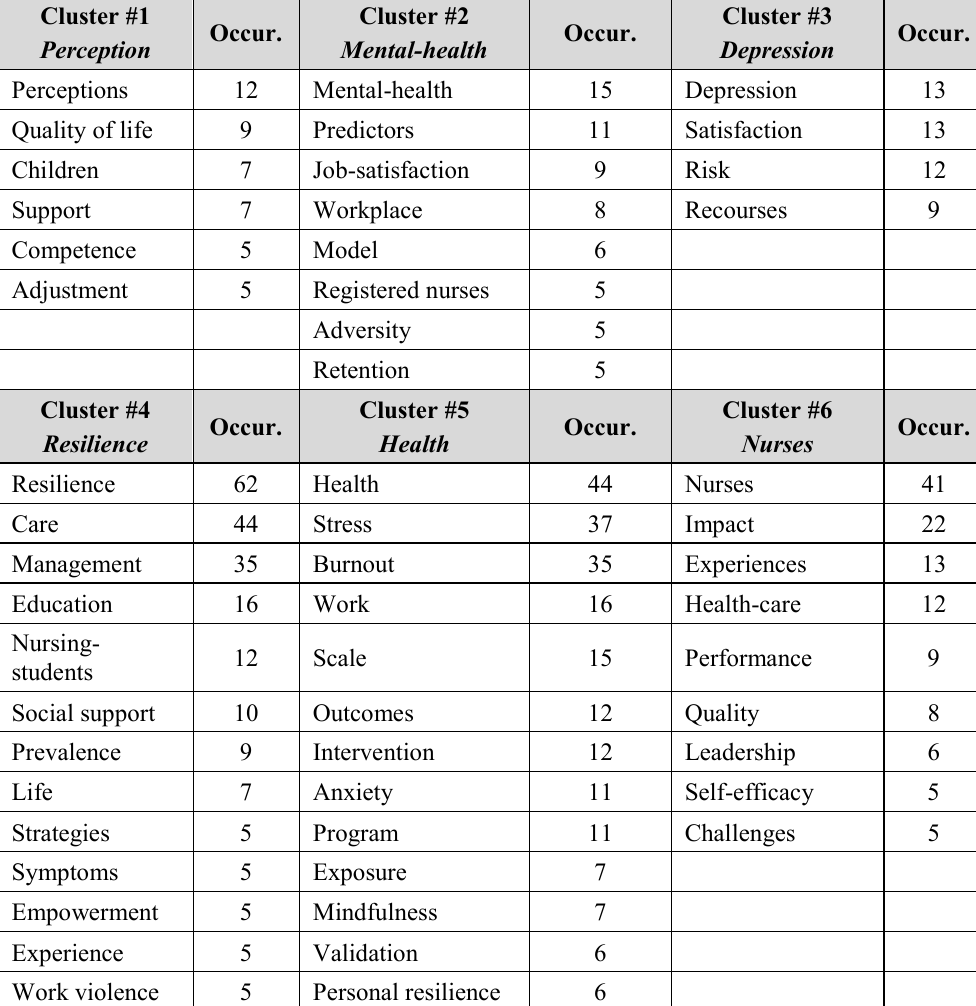
Table 5. Clusters of the Thematic Map, 2005–2022 (up to 7